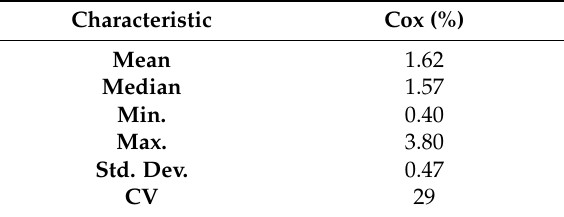
Table 1. Descriptive statistics of Cox.